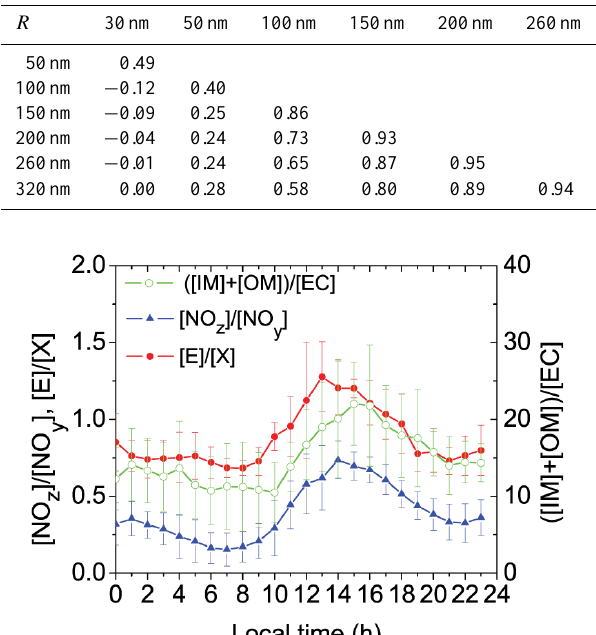
Table 2. Correlation matrix of F in at different diameters (429 data points).